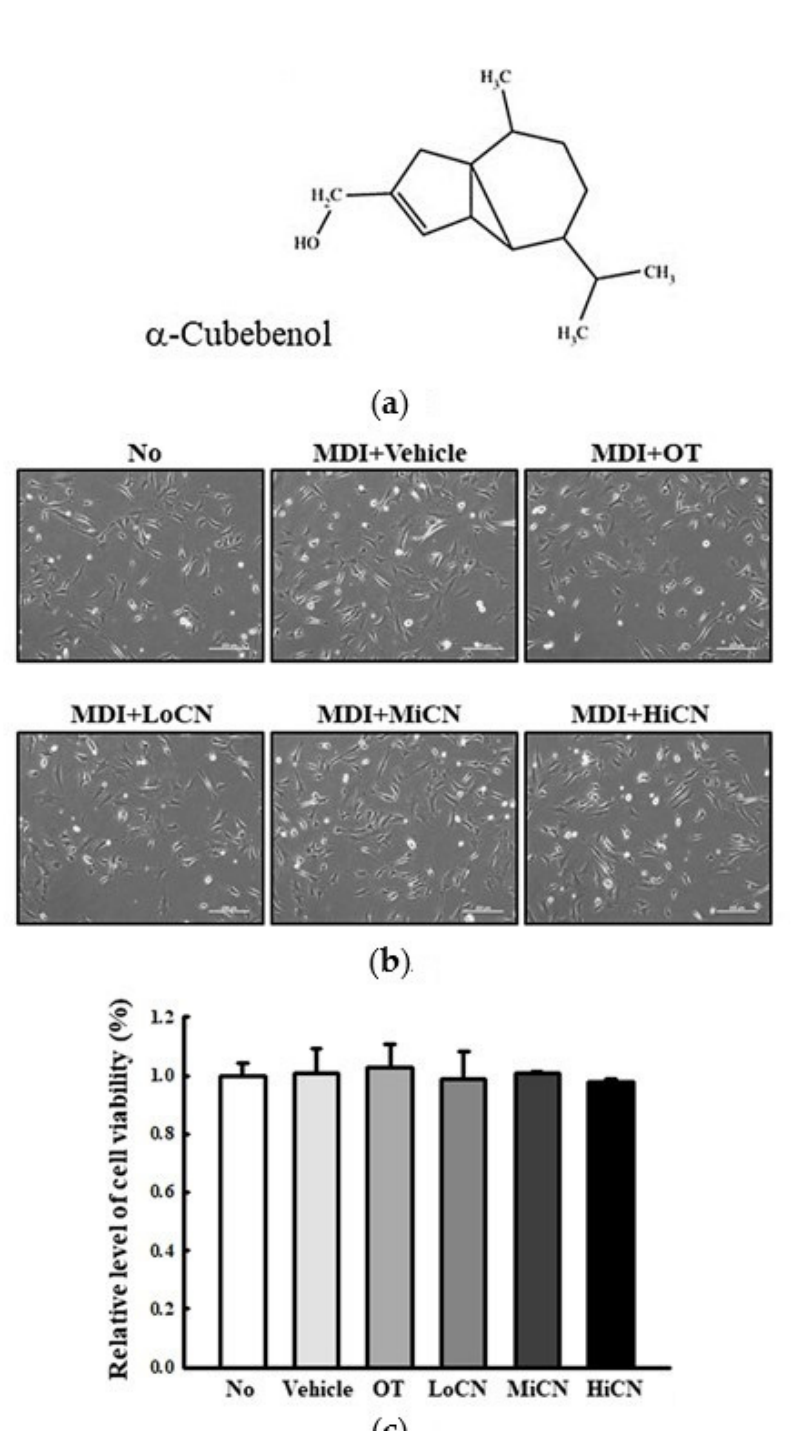
Figure 1. Cytotoxicity. ( a ) Chemical structure of α -cubebenol. ( b , c ) Viability of 3T3-L1 pre-adipocytes against α -cubebenol. After the treatment of 7.5, 15, and 30 μ g/mL of α -cubebenol for 24 h, cell morphological changes were observed under a microscope at 200 × magnification, and the cell viability was determined using the MTT assay. Three wells per group were used for the MTT assay, and optical density was measured in triplicates. The data represents the means ± SD of triplicates. OT, orlistat; MDI, adipogenic cocktail consisting of 3-isobutyl-1-methylxanthine, dexamethasone, and insulin; LoCN, low concentration (7.5 µ g/mL) of α -cubebenol; MiCN, middle concentration (15 µ g/mL) of α -cubebenol; HiCN, high concentration (30 µ g/mL) of α -cubebenol.